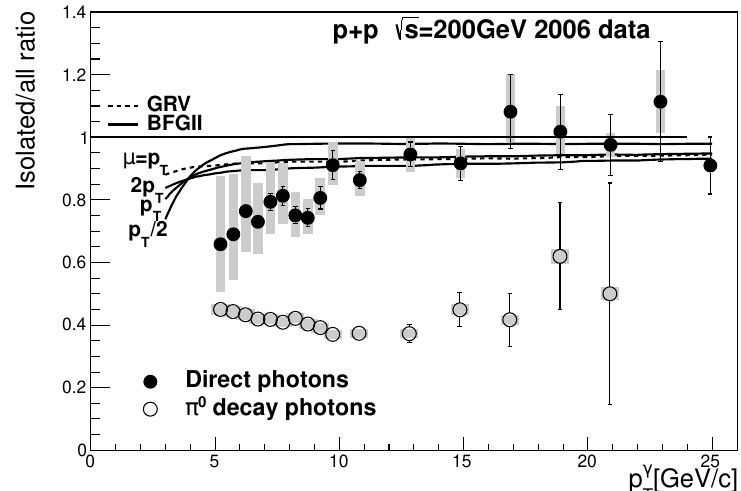
Figure 9. The effect of isolation cut on direct photons and decay photons. Solid circles: ratio of isolated direct photons to inclusive-direct photons. The statistical uncertainties are shown as black error bars and the systematic uncertainties are plotted as shaded bars. The solid and dashed curves are NLO pQCD calculations with three theory scales for BFGII [14] and one scale for the GRV [15] parton to photon fragmentation functions. Open circles: ratio of isolated photons from π 0 decays to all photons from π 0 decays